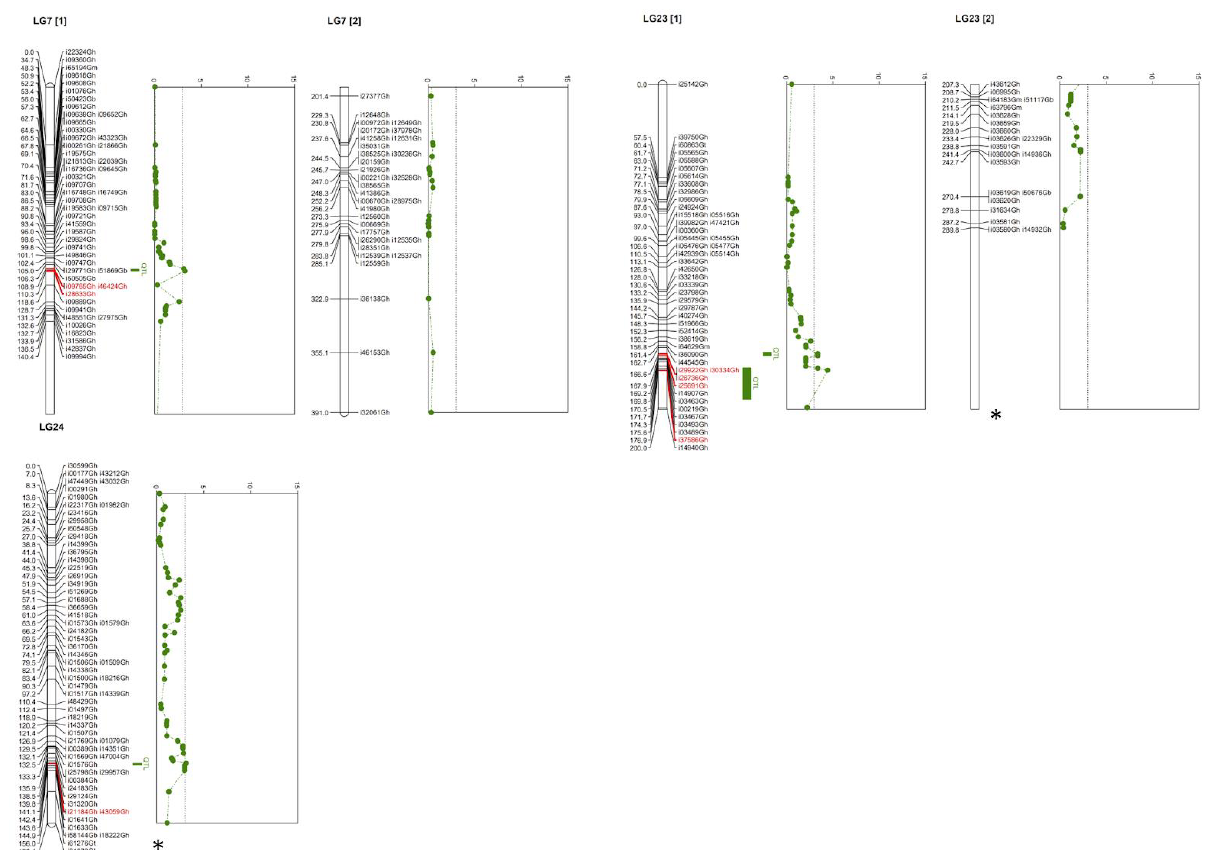
Figure 3. Quantitative Trait Loci identified for Population 6. Linkage Groups 7, 23, and 24 shown for Population 6. Markers associated with QTL are colored in red, and the QTL interval is shown as a green bar to the right of the linkage group. Graph of the likelihood of odds scores (LOD) for each marker is shown to the right of the corresponding linkage group. The dotted line on each graph shows the LOD threshold at 3.0. * Indicate a cut off portion of the linkage group map is not